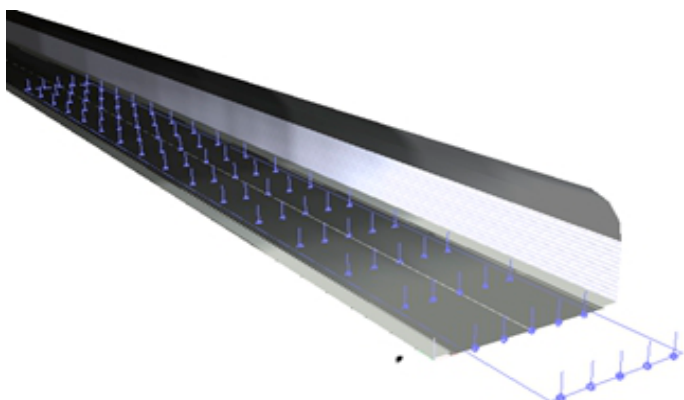
Figure 2. Division of pavement illumination simulation grid.